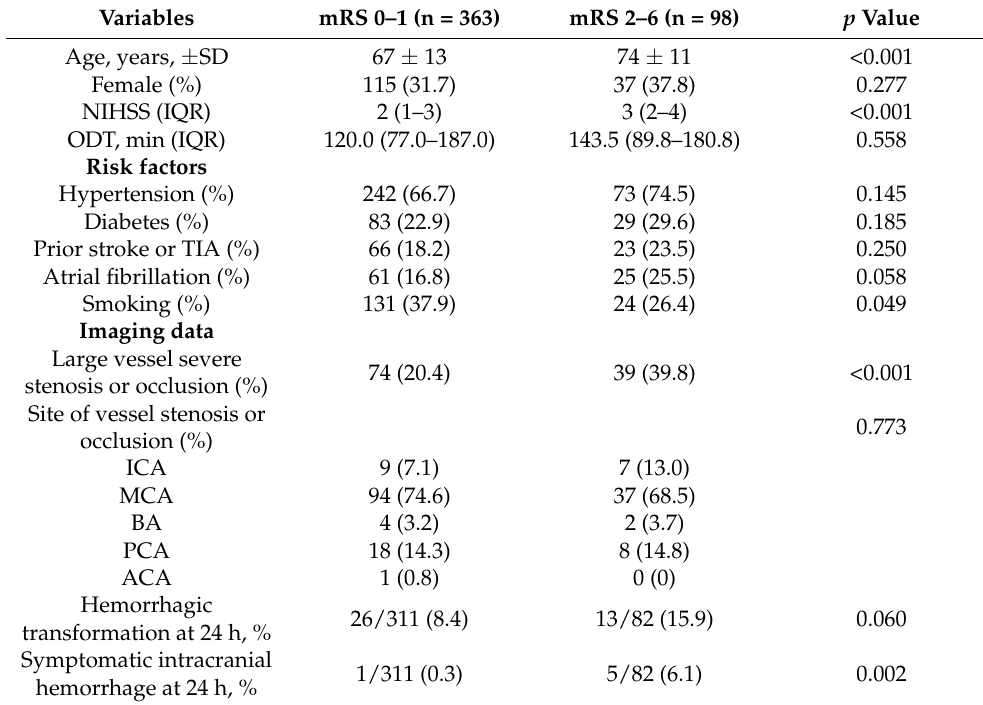
Table 2. Univariate comparison of characteristics in patients with minor non-disabling acute ischemic stroke according to neurological